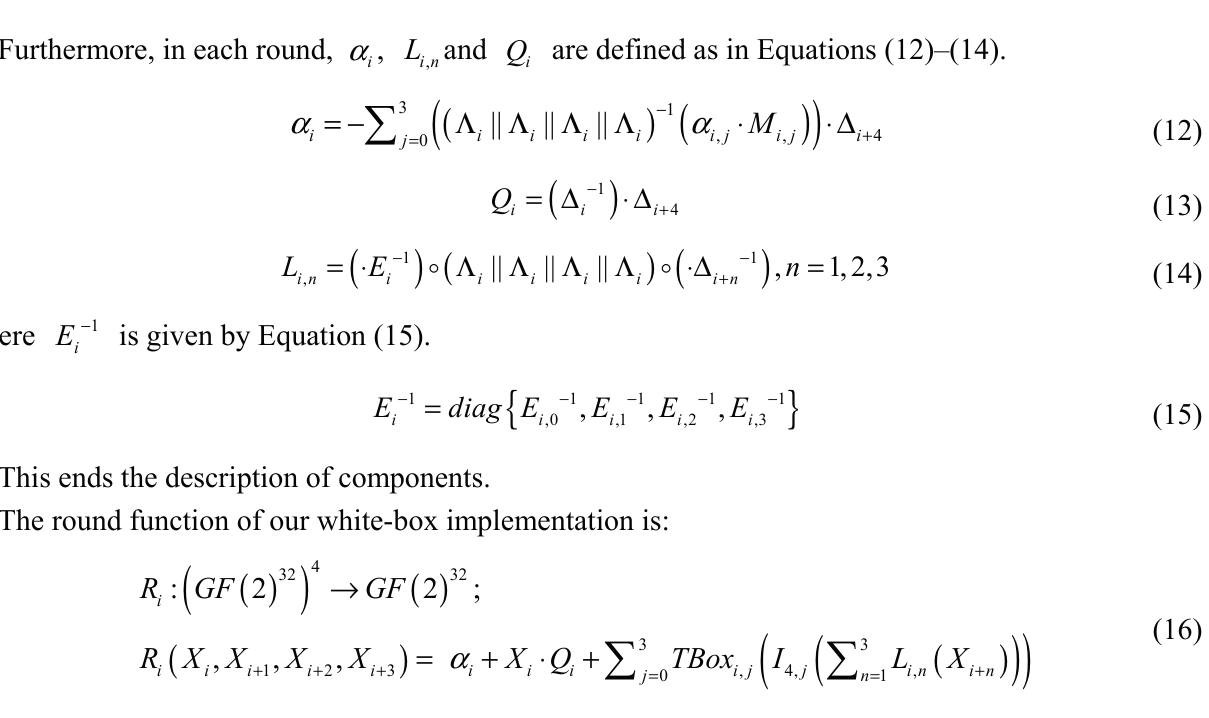
Figure 2. The structure of T-Boxes in a